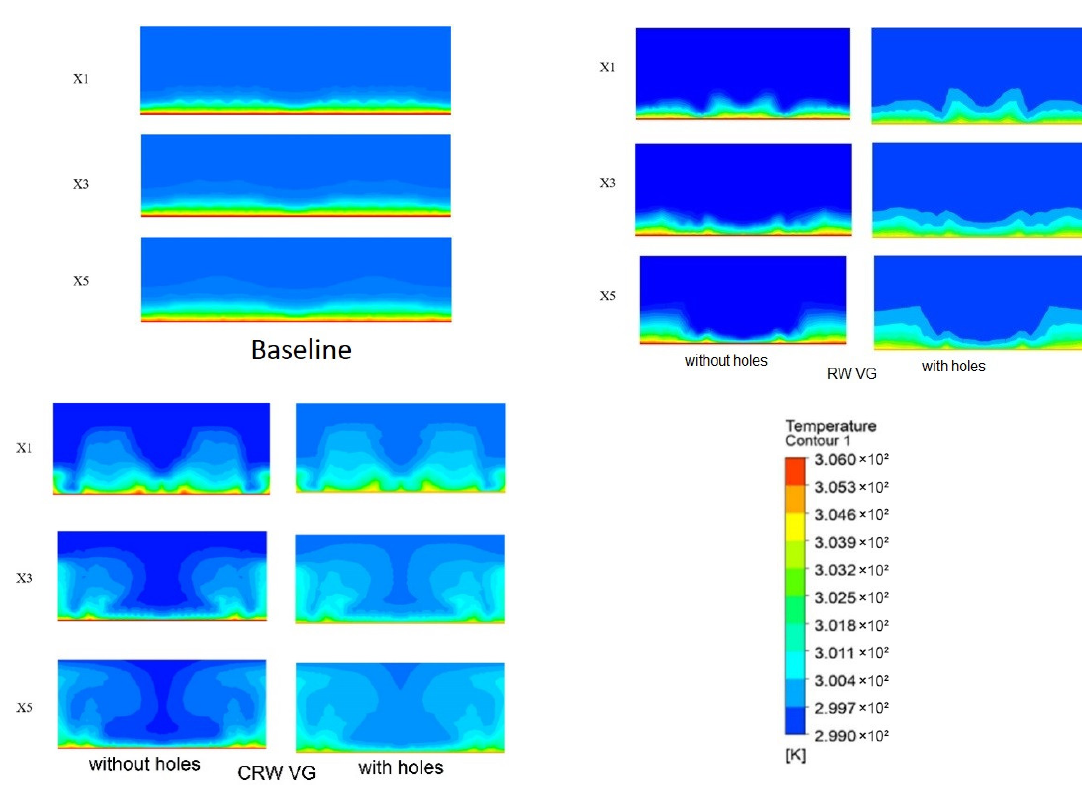
Figure 9. Temperature distribution in the cross-section area at several locations for all cases.